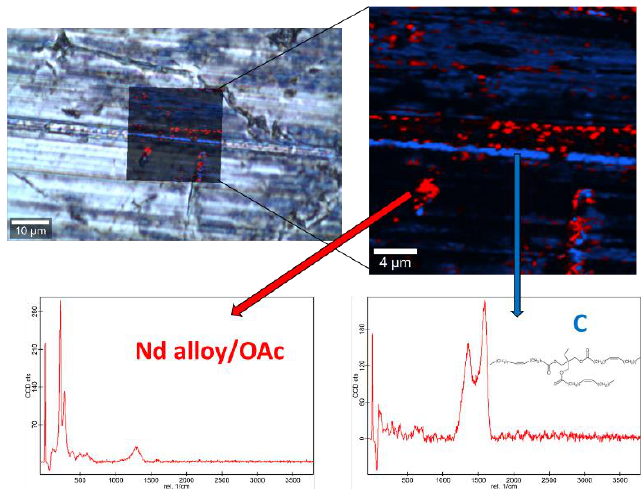
Figure 13. Raman spectra and elemental mapping of the worn surface obtained with the nanolubricant of Fe 3 O 4 (10 nm) nanoparticles.